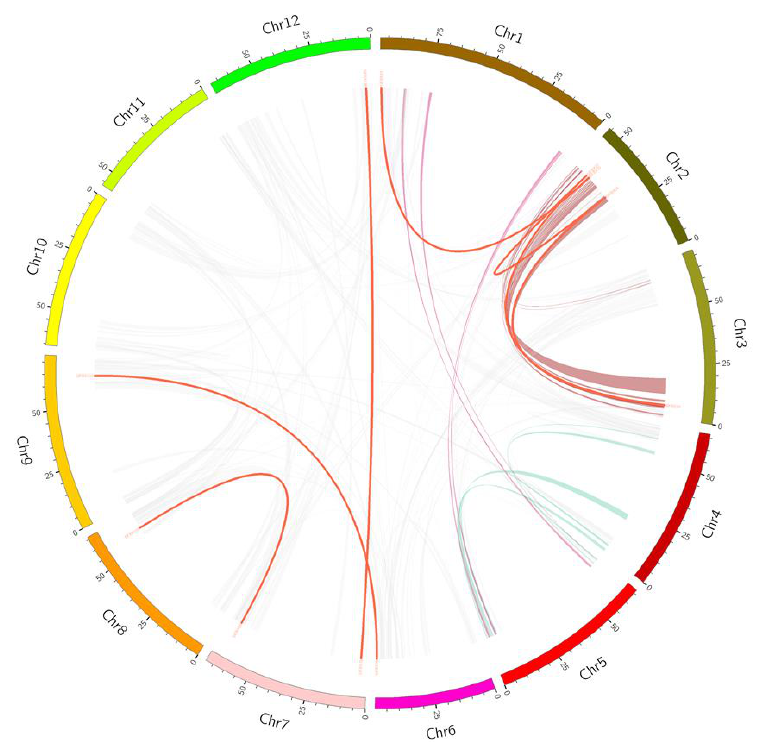
Figure 5. The syntenic pairs of tomato F-box genes from different duplication mode diagrams. The syntenic pairs from whole genome duplication (WGD) were linked by red lines. Purple, green and brown represent syntenic regions with large segments. The others syntenic pairs genes were shown with grey lines.